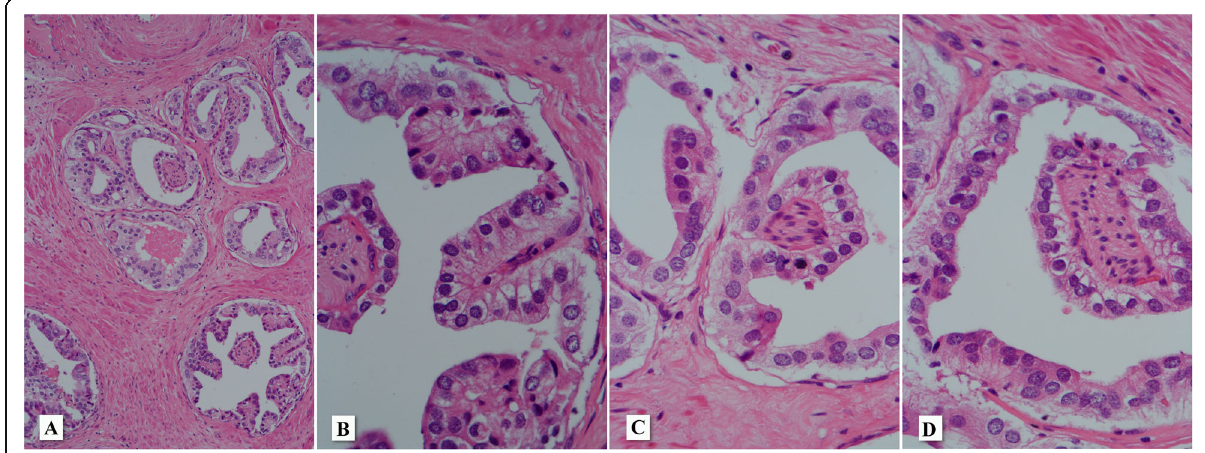
Fig. 4 Other illustrative areas of extensive perineural invasion by prostatic adenocarcinoma with pseudohyperplastic morphology and inverse polarity. Hematoxylin and eosin stain: A (100x), B (400x), C (100x) and D